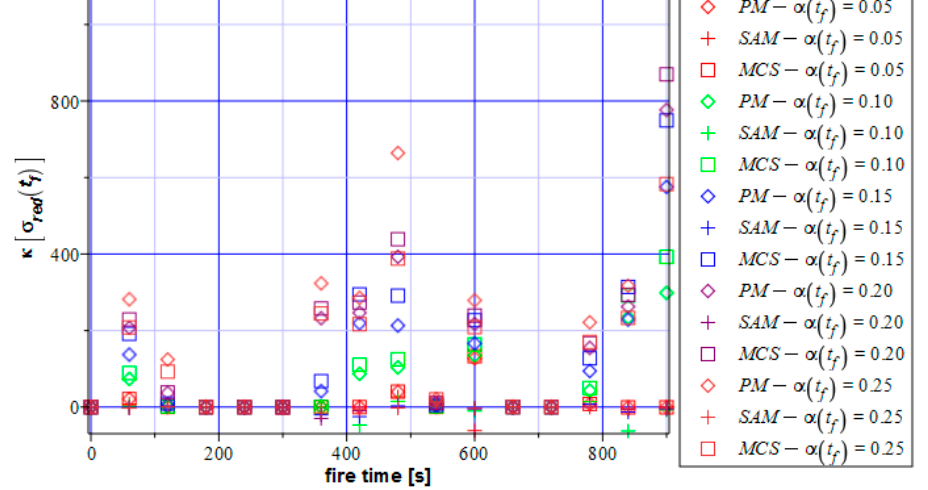
Figure 18. Kurtosis of the reduced stress.